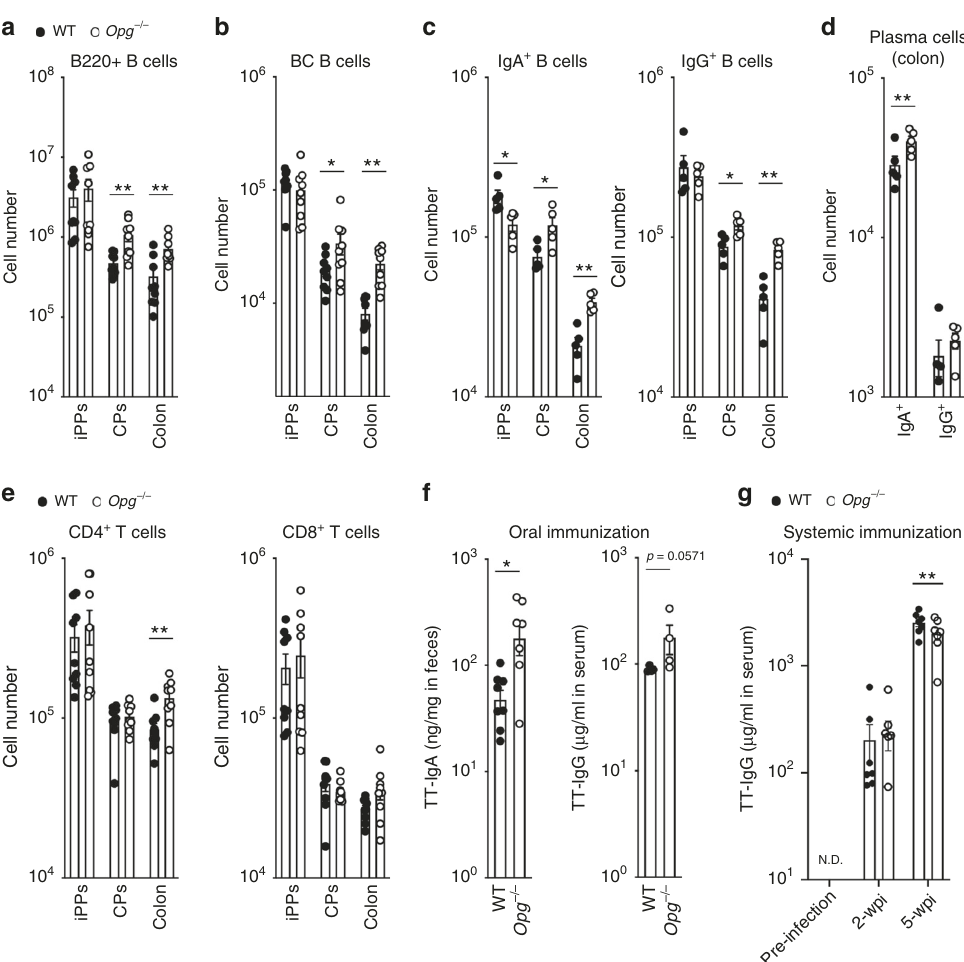
Fig. 5 Absence of Opg promotes mucosal immune responses in the gut. a – c The numbers of B cells ( a ), germinal center (GC) B cells ( b ), IgA + B cells and IgG + B cells ( c ) in ileal Peyer ’ s patches (iPPs), cecal patches (CPs), and whole colons were quanti fi ed by fl ow cytometry. d The numbers of IgA + and IgG + plasma cells in the colons were quanti fi ed by fl ow cytometry. Data are presented as the mean ± standard error ( a , b , e ) or standard deviation ( c , d ). ** p < 0.01, * p < 0.05; p values were calculated with the Student ’ s t -test ( a and b , n = 9 animals from two independent experiments; c and d , n = 5 animals, representative of two independent experiments). e The numbers of CD4 + T cells (left) and CD8 + T cells (right) in iPPs, CPs, and whole colon were quanti fi ed by fl ow cytometry. ** p < 0.01; Student ’ s t -test, n = 9 animals from two independent experiments. f Feces and sera were collected from Opg − / − or co-housed WT mice at 4 weeks after oral immunization with 5 × 10 7 c.f.u. of Salmonella -ToxC. The amounts of ToxC-speci fi c-IgA in feces (left) and -IgG in serum (right) were evaluated by ELISA. Data are presented as the mean ± standard error (left) or standard deviation (right) (left, Welch ’ s t -test; n = 9 animals from two independent experiments; right, Mann – Whitney U test, n = 4 animals of representative of two independent experiments). g Sera were collected from Opg − / − or littermate WT mice at indicated time periods after intraperitoneal immunization with 5 × 10 5 c.f.u. of Salmonella -ToxC. The amount of ToxC-speci fi c-IgG in serum was evaluated by ELISA. Data are presented as the mean ± standard error ( n = 7 of littermate and co-housed WT, n = 7 of Opg − / − mice from two independent experiments). * p < 0.05 calculated with two-way ANOVA. The source data underlying panels a – g are provided as a Source Data fi